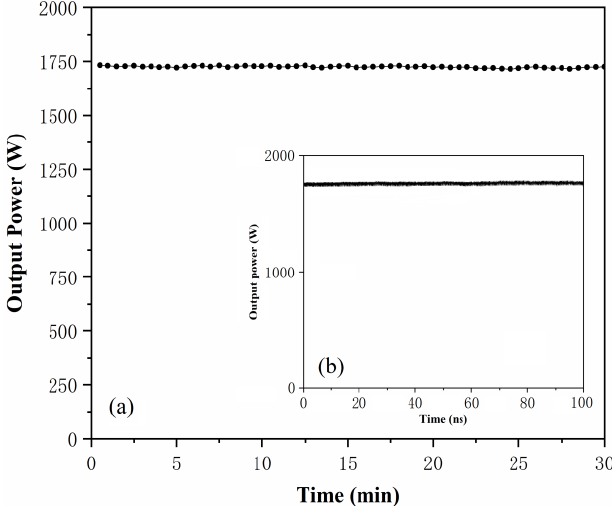
Figure 7. ( a ) Continuous output power stability. ( b ) Stable output of power in the nanosecond ranges).